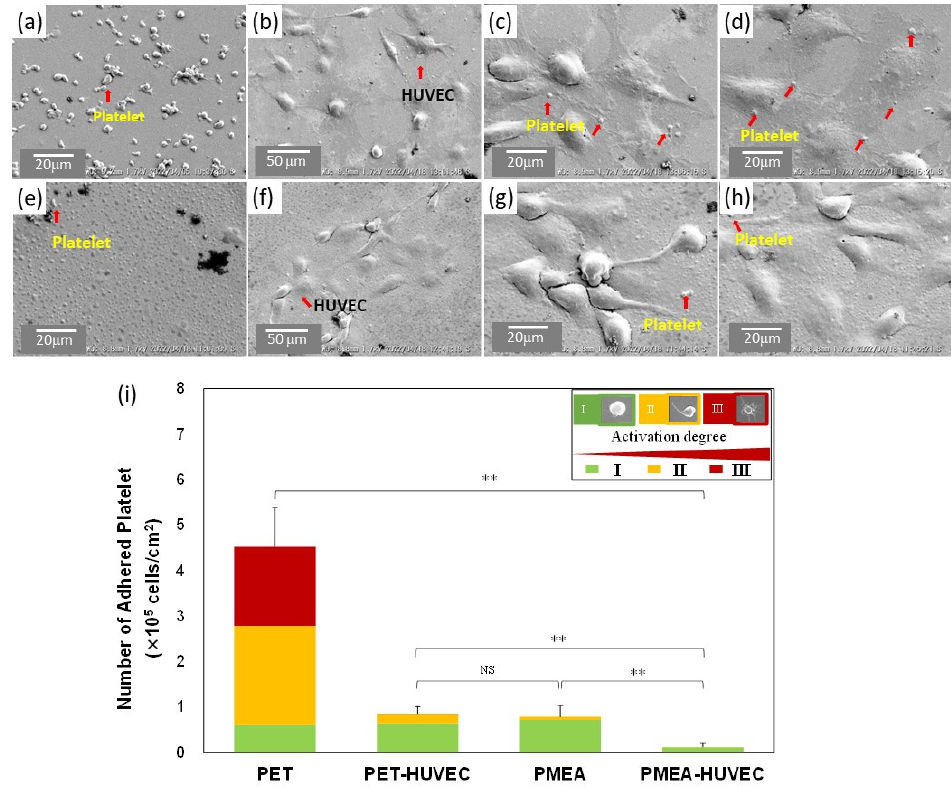
Figure 10. SEM image of ( a ) bare PET; ( b ) HUVEC monolayer on PET (scale bar = 50 µ m); ( c , d ) HUVEC monolayer on PET (scale bar = 20 µ m); ( e ) bare PMEA; ( f ) HUVEC monolayer on PMEA (scale bar = 50 µ m); and ( g ) and ( h ) HUVEC monolayer on PMEA (scale bar = 20 µ m). Red arrows indicate the typical positions of observed cells. ( i ) Number of adhered platelets counted from SEM images. The data represent the means ± SD, n = 15, ** p < 0.05; NS means not significant deference).